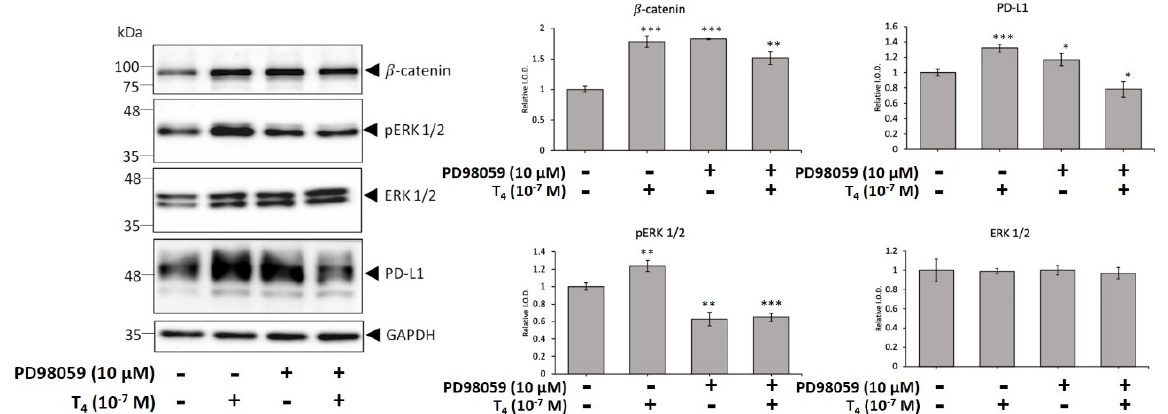
Figure 2. ERK1/2 activation plays a role in T 4 -induced accumulation of PD-L1 and β-catenin in human oral cancer OEC-M1 cells. Oral cancer OEC-M1 cells were seeded in six-well trays and were